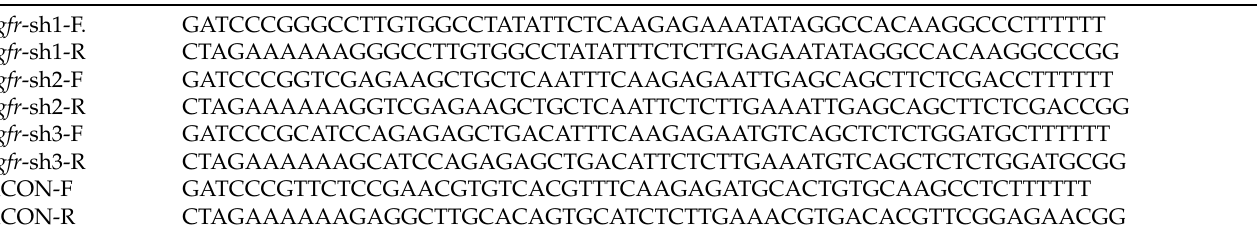
Table 2. NGFR shRNA and control